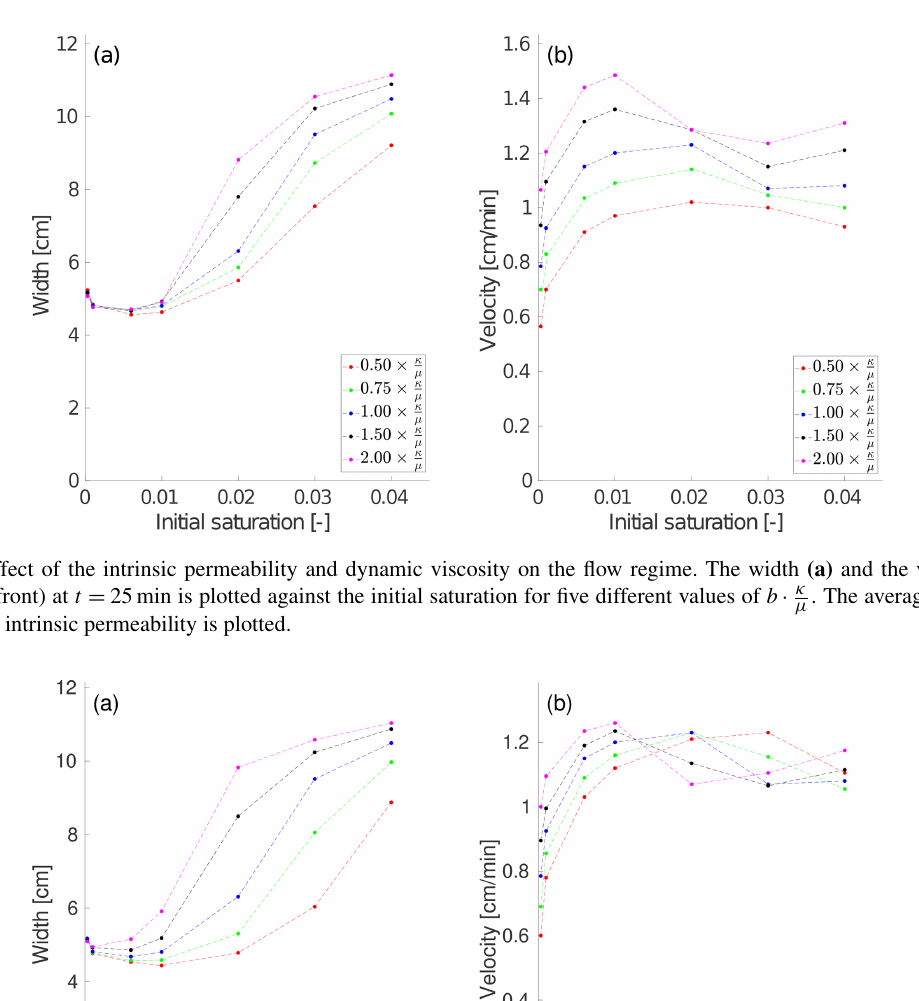
Figure B3. The effect of the relative permeability on the flow regime. The width (a) and the velocity (b) of the finger (or wetting front) at t = 25min is plotted against the initial saturation for five different values of parameter λ . The average of four different distributions of the intrinsic permeability is